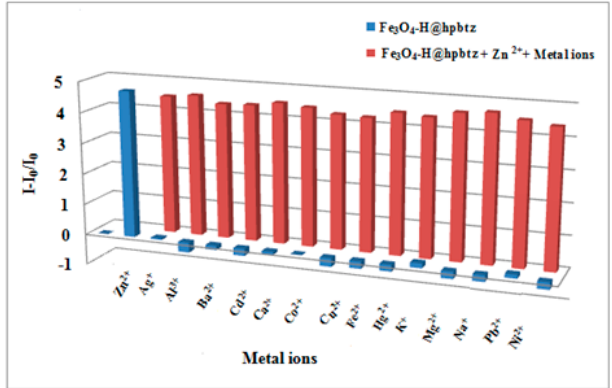
Figure 14. Variation of the fluorescence intensity of Fe 3 O 4 -H@hpbtz (2 mg mL − 1 ) with Zn 2+ (7.8 equivalent, 300 µL) and various metal ions (2 times more in equivalent) at 460 nm ( λ ex = 350 nm) in ethanol.